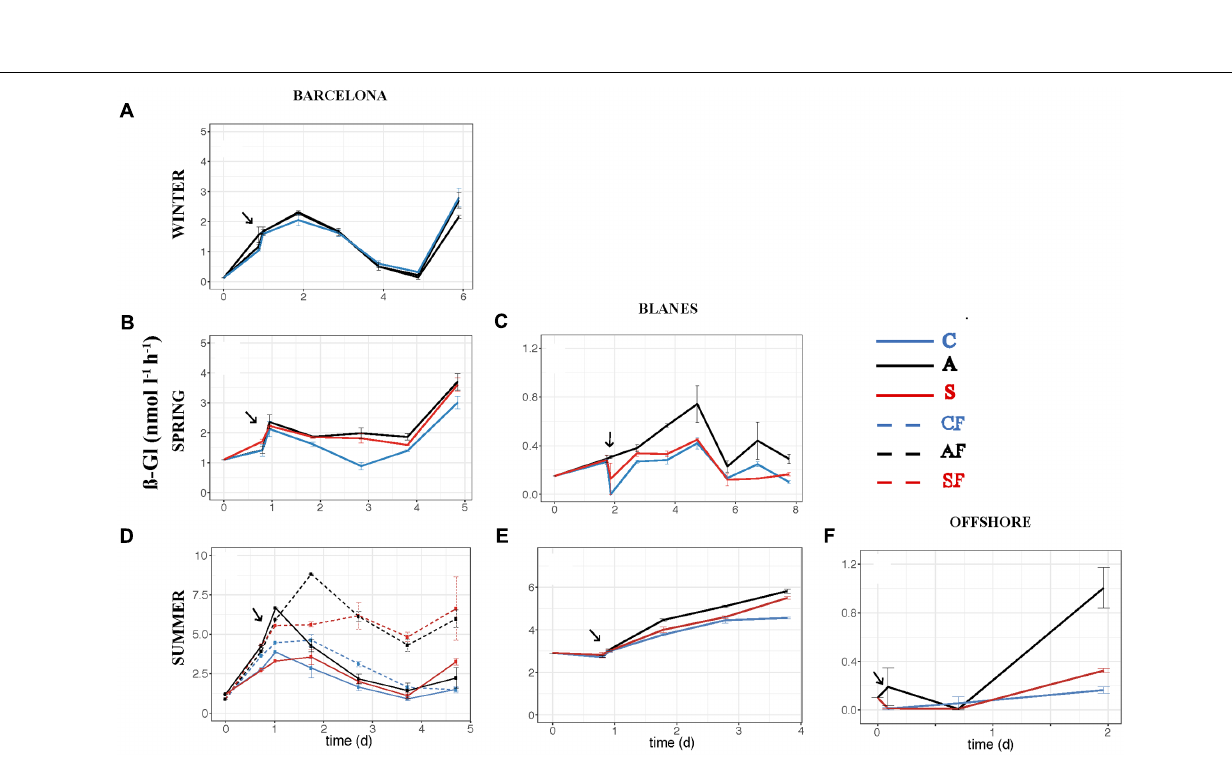
Frontiers in Microbiology |